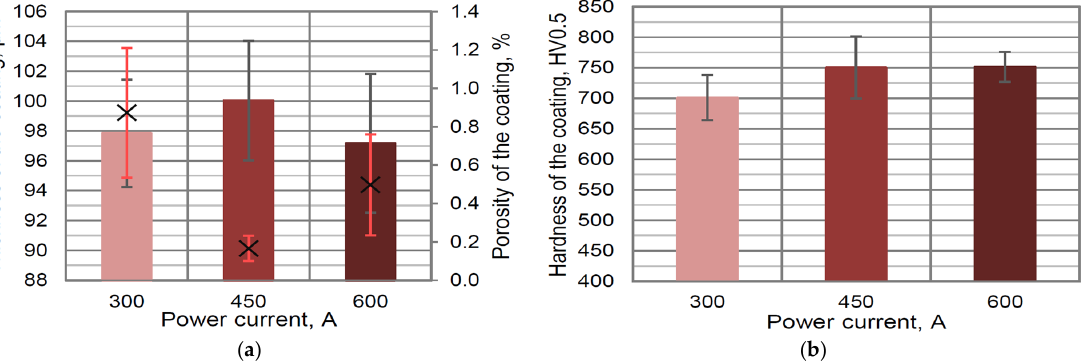
103 μ m (Figure 4a). The highest hardness—750 HV0.5—was measured when the medium value of hydrogen flow (68/5 NLPM) rate was used (Figure 4b). The lower hardness (663 Figure 3. The influence of power current on thickness/porosity (in the figure, the porosity is marked as x) ( a ) and hardness ( b ) of developed coating containing 10 wt. % YSZ additions. The influence of the plasma gas composition (especially the hydrogen flow rate) was a second analyzed factor for plasma-spraying parameter selection. The use of a low flow rate of hydrogen in a plasma plume (2 NLPM) does not enable full particle melting and finally provides a high porosity of the obtained coating (0.39 vol. %) (Figure 4a). A similar